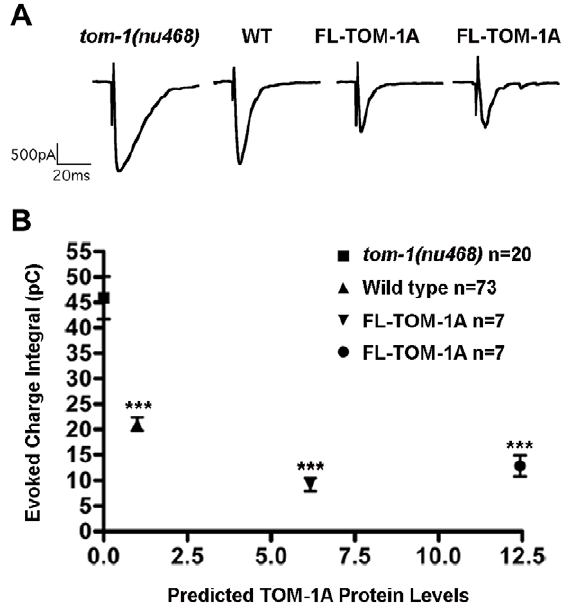
Figure 1. Inverse-relationship between predicted full-length TOM-1A expression levels and synaptic function. A. Represen- tative evoked post-synaptic responses from the NMJ of tom-1(nu468) , wild type and two TOM-1A integrated lines, SY1229 and SY1242, expressed in the tom-1(nu468) mutant background respectively. B. Average charge integral for evoked responses of tom-1(nu468) (n=20), wild type (n=73) and tom-1(nu468) over-expressing TOM-1A integrated lines SY1242 ( , 6 fold mRNA levels) (n=7) and SY1229 ( , 12 fold mRNA levels) (n=7) plotted against predicted TOM-1A expression levels based on quantitative real-time RT-PCR (qRT-PCR) normalized to C. elegans actin ( act-1 ) transcript levels. Data plotted as mean 6 SEM (significance values relative to tom-1(nu468) , *** p # 0.0001, Mann Whitney T-test). Representative evoked NMJ traces are displayed above each strain.